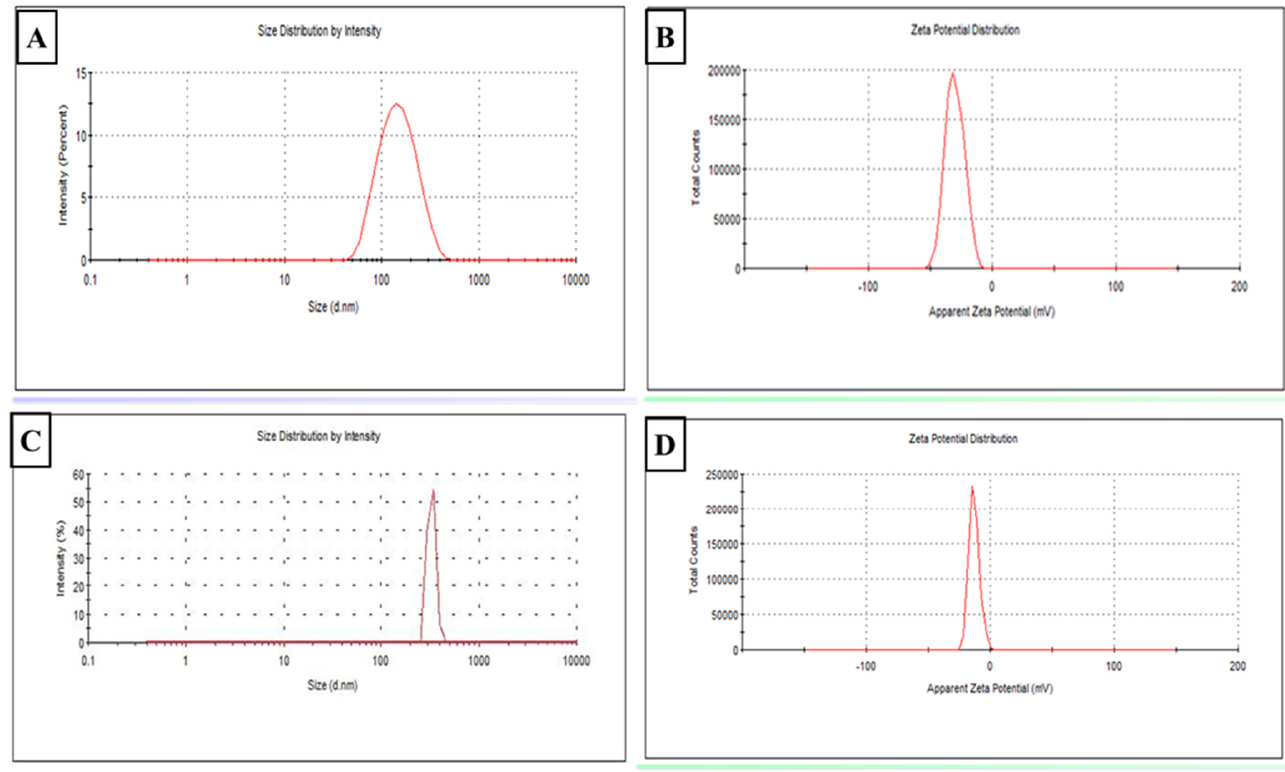
Figure 2. Colloidal characterization of freshly prepared plain and MLT-SLNs suspensions (at zero- day). (A) Particle size curve distribution for plain SLNs. (B) Zeta potential curve of plain SLNs. (C) Particle size distribution curve of MLT-SLNs. (D) Zeta potential curve of MLT-SLNs.